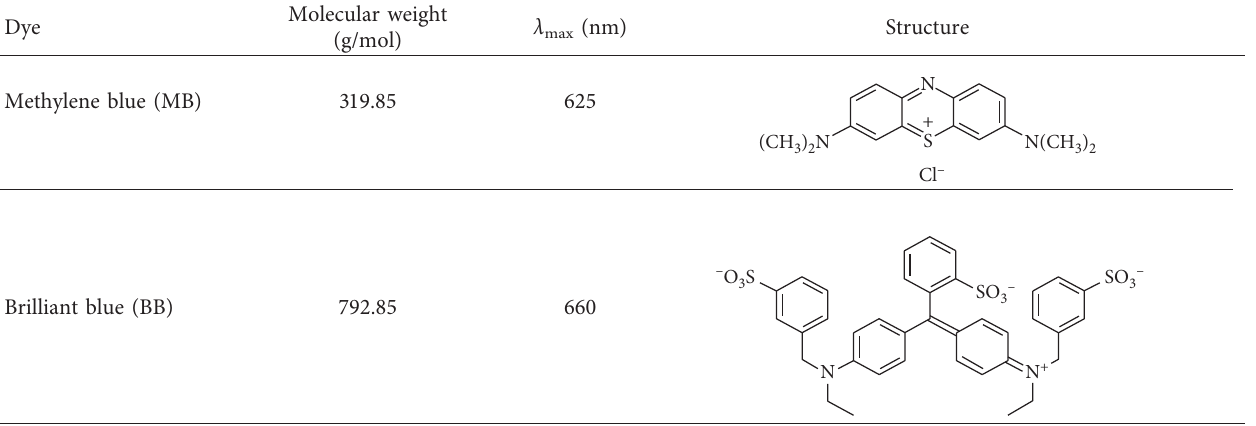
Table 1: Chemical and physical properties of methylene blue and brilliant blue.